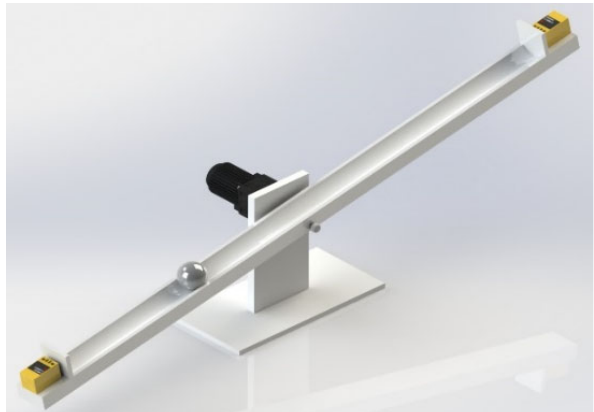
Figure 1. Three ‐ dimensional graphic of ball and beam system DS SolidWorks ® , 2020 SP5.0 Pre ‐ Figure 1. Three-dimensional graphic of ball and beam system DS SolidWorks ® , 2020 SP5.0 Pre- mium x64 . mium